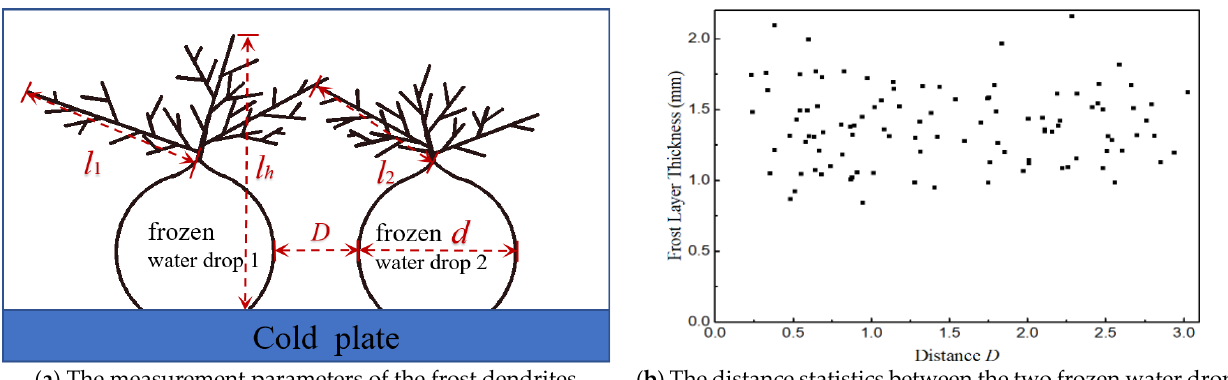
Figure 5. Illustration of frost crystal dendrite measurement parameters.